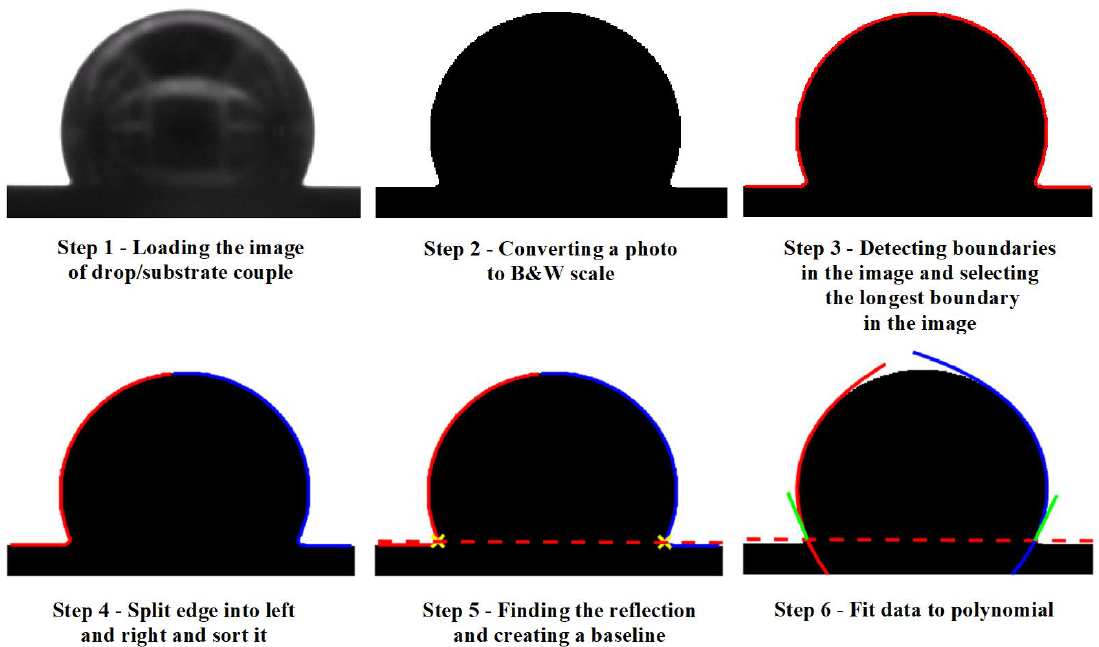
Figure 6. Step-by-step implementation of the contact angle fitting algorithm using the drop shape analysis program script [46,47].